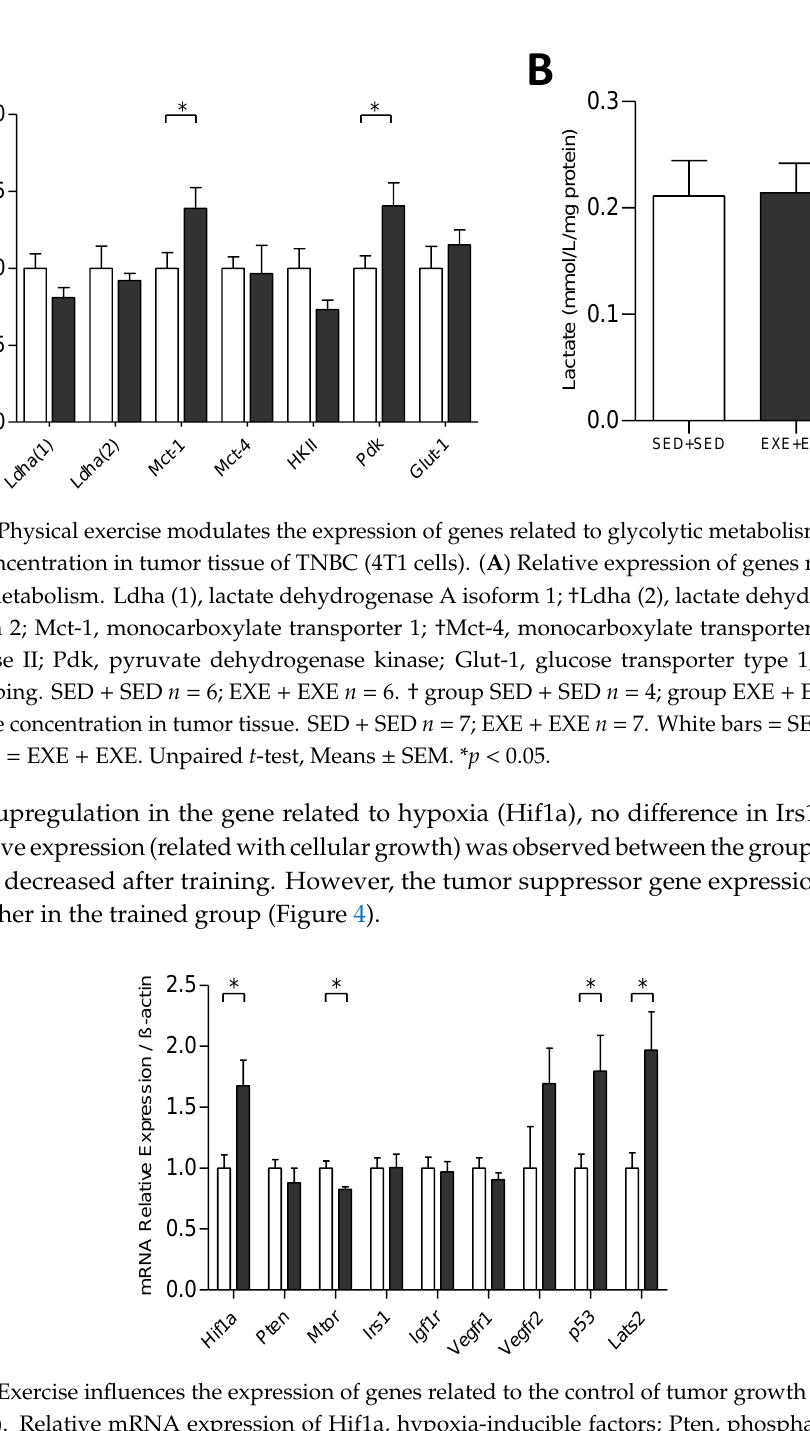
Figure 4. Exercise influences the expression of genes related to the control of tumor growth in TNBC (4T1 cells). Relative mRNA expression of Hif1a, hypoxia-inducible factors; Pten, phosphatase and tensin homolog; Mtor, mammalian target of rapamycin; Irs1, insulin receptor; Igfr1, insulin-like growth factor 1 receptor; Vegfr (1–2), vascular endothelial growth factor receptor; p53, tumor protein p53; Lats, large tumor suppressor; β -actin, housekeeping, SED + SED n = 4; EXE + EXE n = 4. White bars = SED + SED, gray bars = EXE + EXE. Unpaired Student t -test, Means ± SEM.* p < 0.05